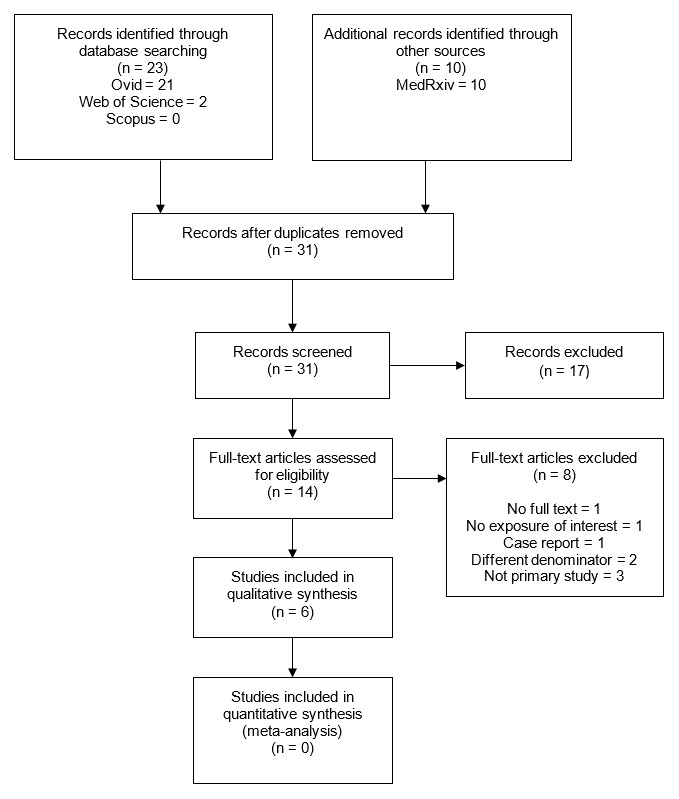
Selection process.